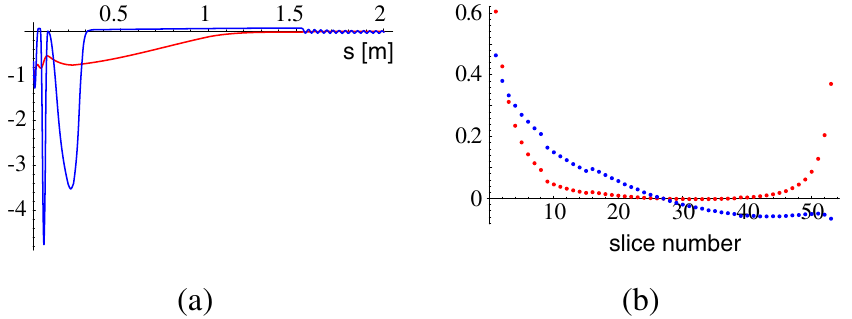
(cid:1) (cid:1) and (cid:2) (cid:2) (cid:1) (cid:1) ^ (cid:1) into (a) common (cid:1) (cid:2) s ^ (cid:1) (cid:1) (cid:2) s